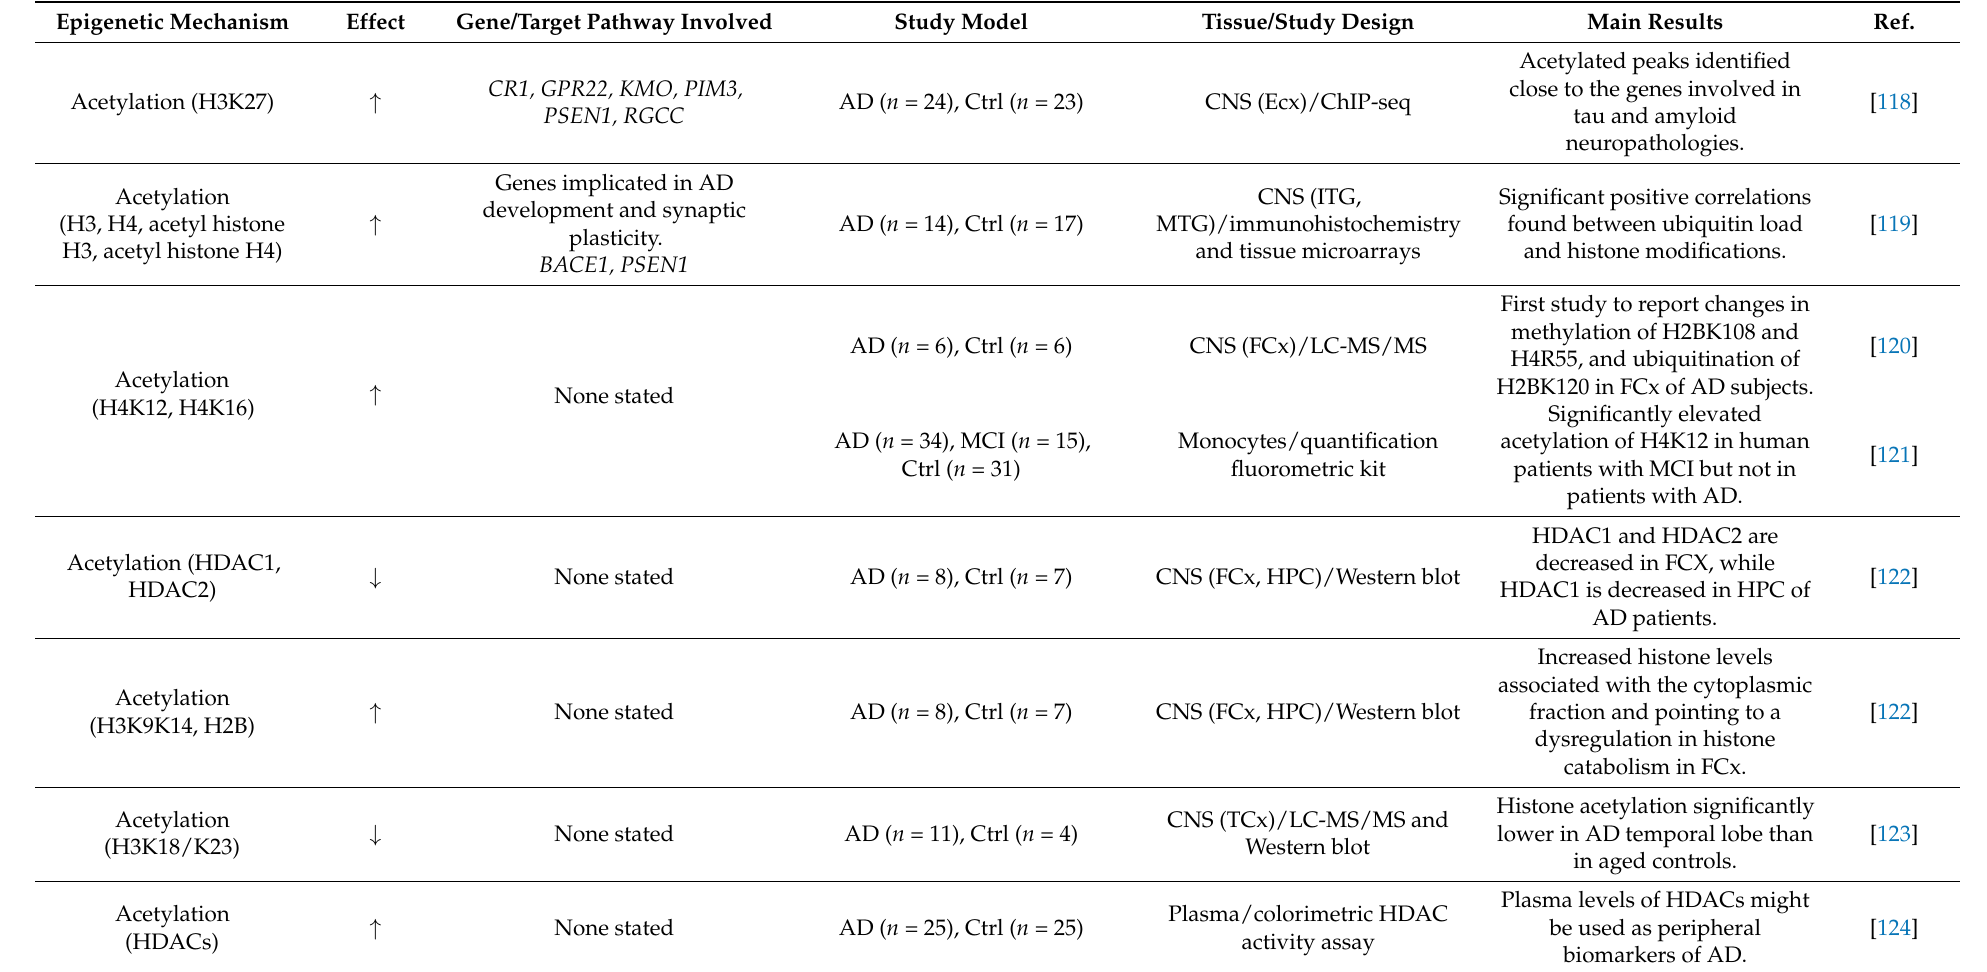
Table 3. Overview of studies investigating histone modifications in